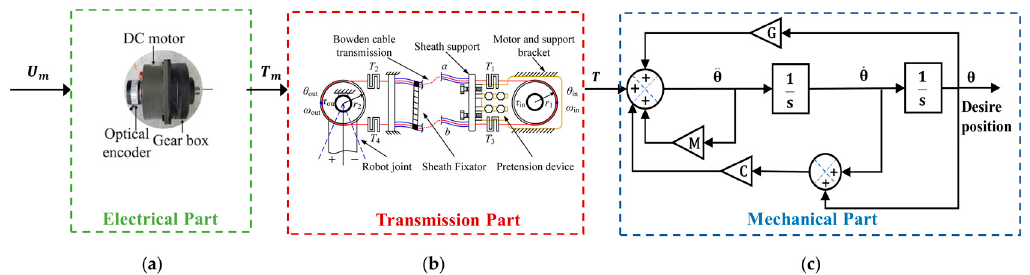
Figure 3. The block diagram of CLLE. ( a ) DC motor and encoder of the electrical part; ( b ) the trans- mission system of the CTSA; ( c ) the block diagram of mechanical part.